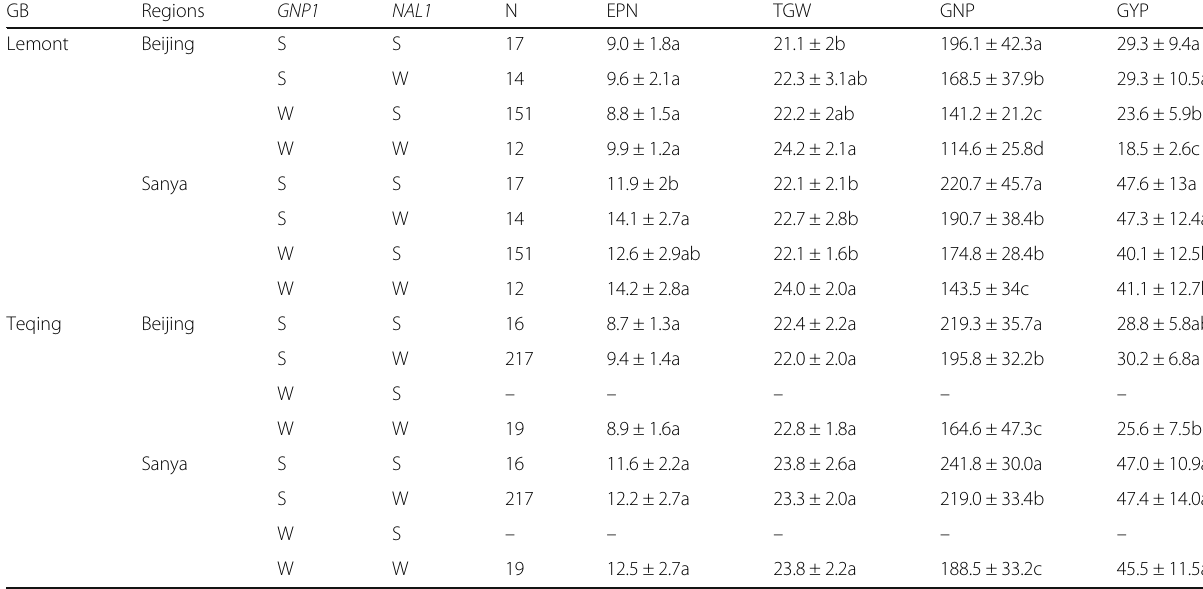
Table 3 Grain yield and their related traits associated with the combination lines of NAL1 and GNP1 GB Regions GNP1 NAL1 N EPN TGW GNP GYP Lemont Beijing